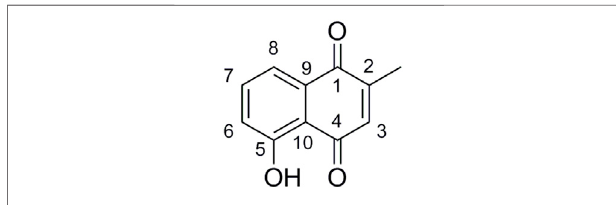
FIGURE 3 | Structure of plumbagin.